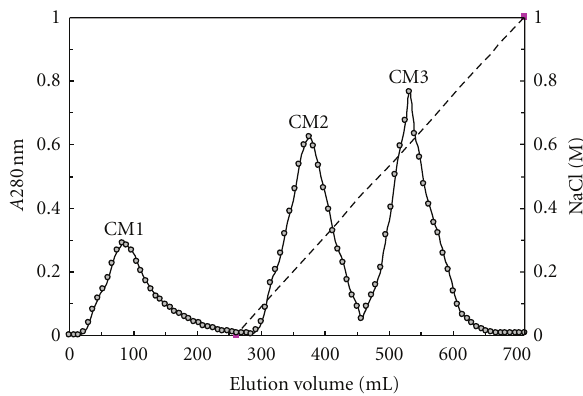
Figure 1: Ion exchange chromatography on CM-cellulose. Sample: fraction Q3. Fraction size: 8mL. Flow rate: 2mL/min. Dotted line across right-hand side of chromatogram indicates linear NaCl concentration (0-1M) gradient used to CM2 and CM3.